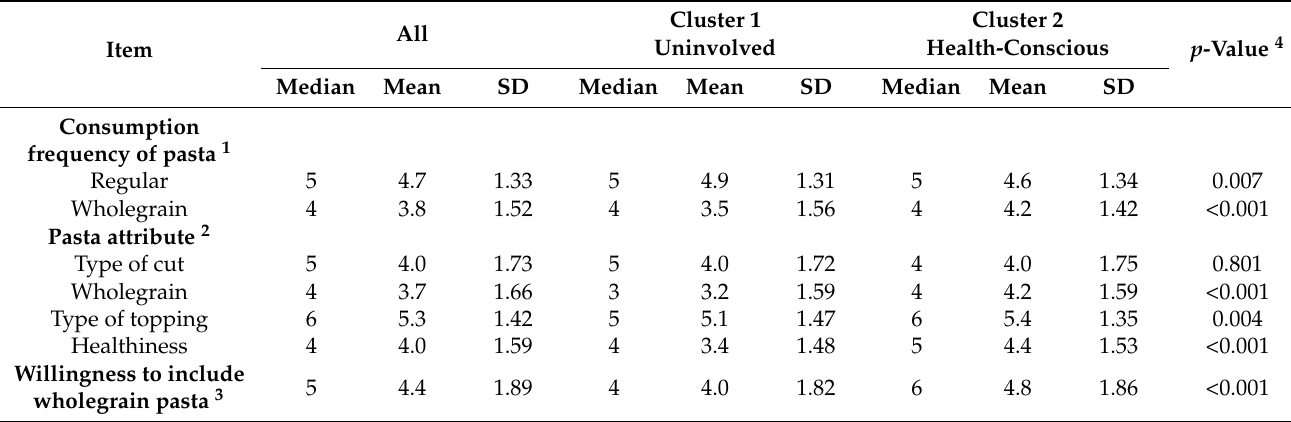
Table 2. Consumption frequency of pasta and attributes that affect the pasta consumption of the total sample, Cluster 1 and Cluster